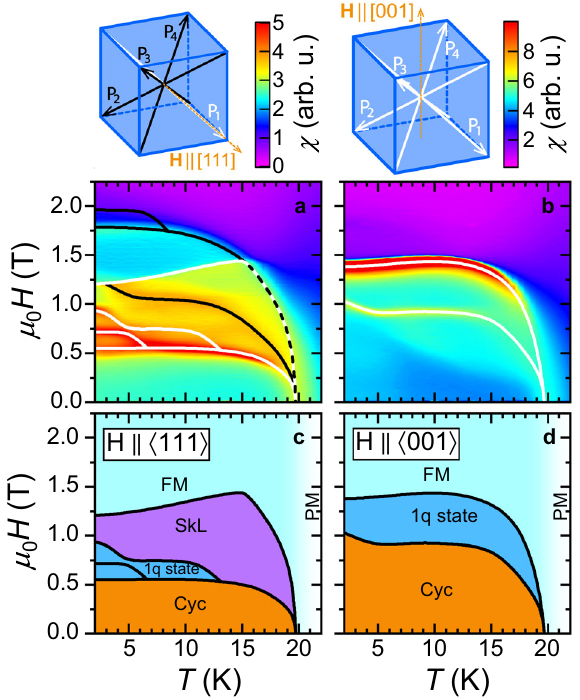
Fig. 5 Magnetic fi eld and temperature dependence of the phase diagram for fi eld parallel to the [111] and [001] directions. The magnetic suscpetibility as a function of magnetic fi eld and temperature is shown for fi eld parallel to the [111] and [001] directions in panel a and b , respectively. The direction of the magnetic fi eld with respect to the four polar axes (P 1 − 4 ) is indicated above the colour plots. The lines indicate anomalies of the susceptibility corresponding to phase transitions. For H ∥ [111] transitions occurring in the P 1 domain are highlighted by white lines whereas phase boundaries of the P 2 − 4 domains are drawn in black. For H ∥ [001] all four domains are indistinguishable. Panel c and d display schematic phase diagrams deduced for a polar mono- domain sample for fi elds respectively spanning zero and 55 ∘ with the polar